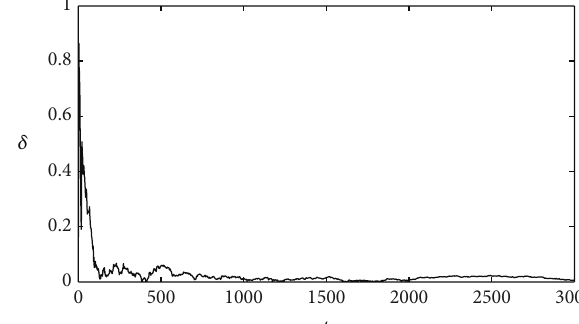
Figure 2: The SG estimation error 𝛿 versus 𝑡 .